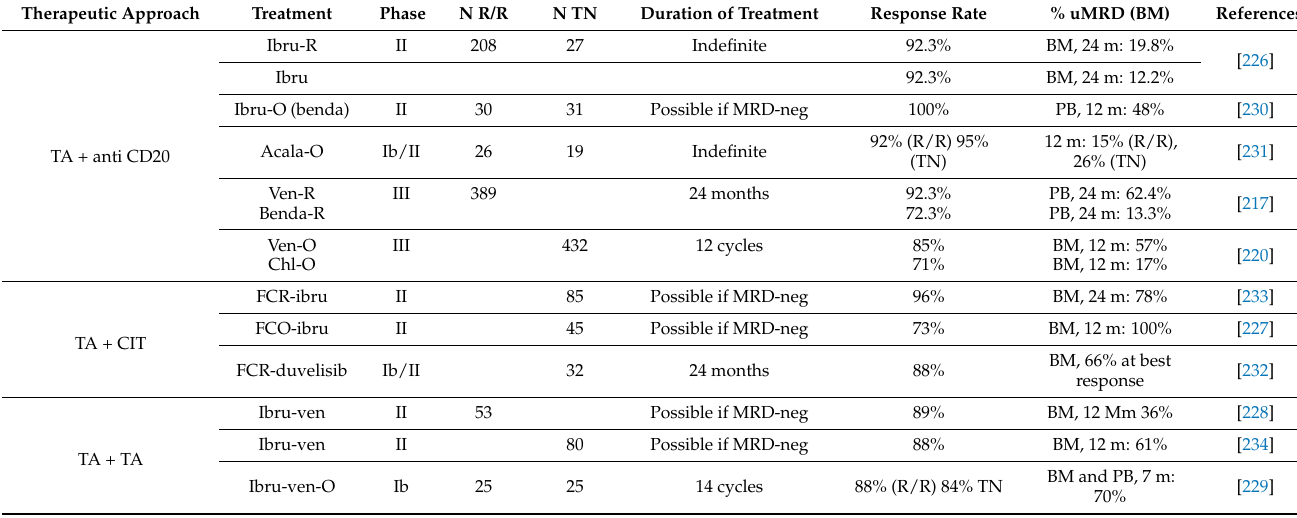
Table 3. Trials using new combinations of novel agents with anti-CD20, chemoimmunotherapy and between them for CLL. Therapeutic